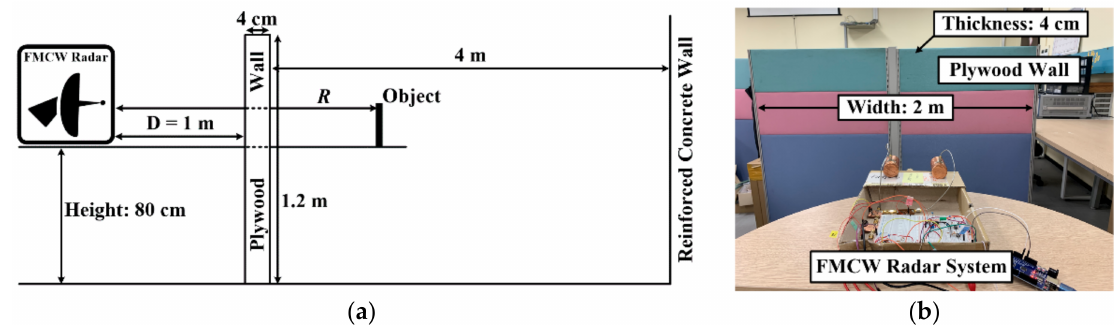
Figure 9. ( a ) Through-wall detection measurement setup and ( b ) measurement